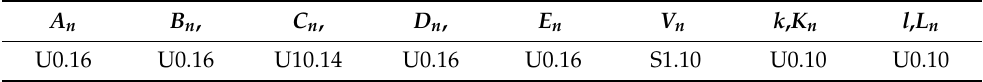
Table 1. Parameters input to the scatterer generator and their mathematical representations. A